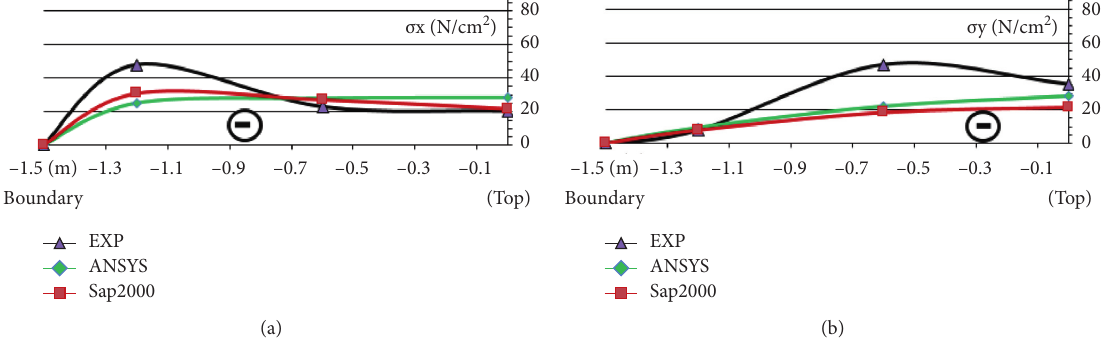
Figure 11: Stresses in the methods: (a) stress σ